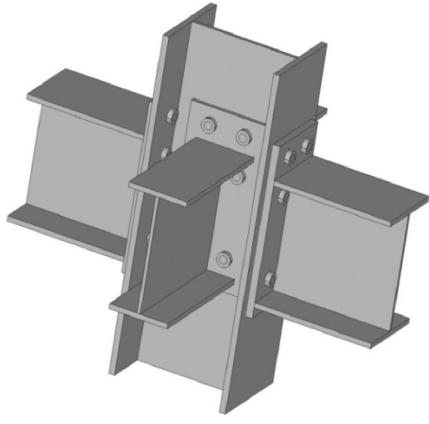
Figure 8: A spatial joint.